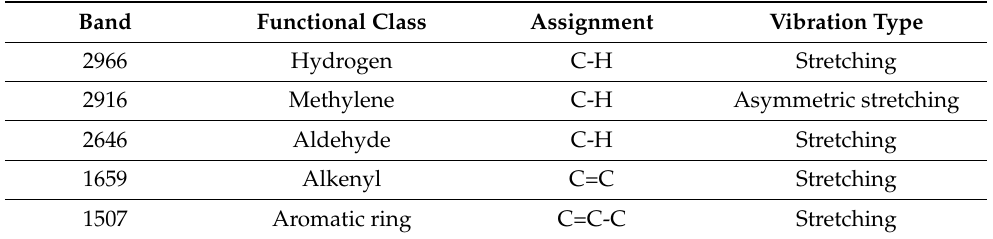
Table 7. Characteristics, chemical properties, functional groups, and vibration types of JCJC spent tea leaf